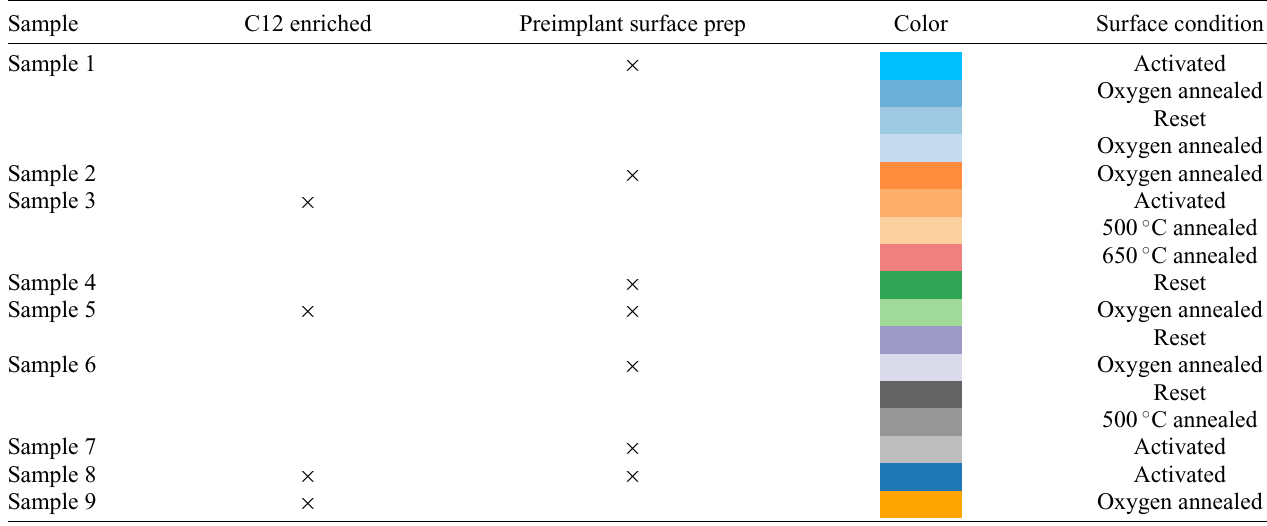
TABLE I. Diamond